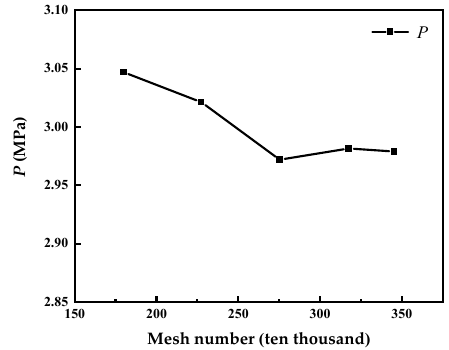
Figure 6. Grid independence analysis.